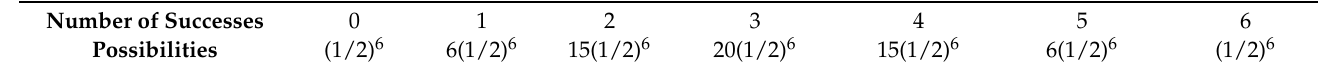
Table 3. Aburthnot’s binomial phenomenon reasoning (adapted from from